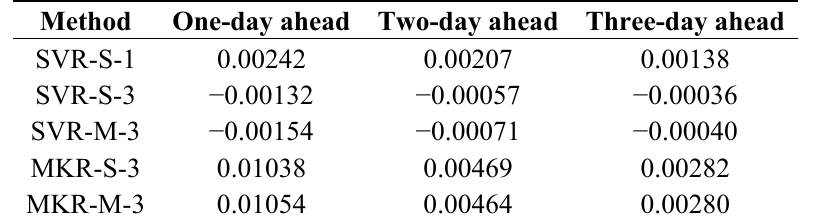
Table 7. Average APP results for Brent crude oil price prediction (total 14